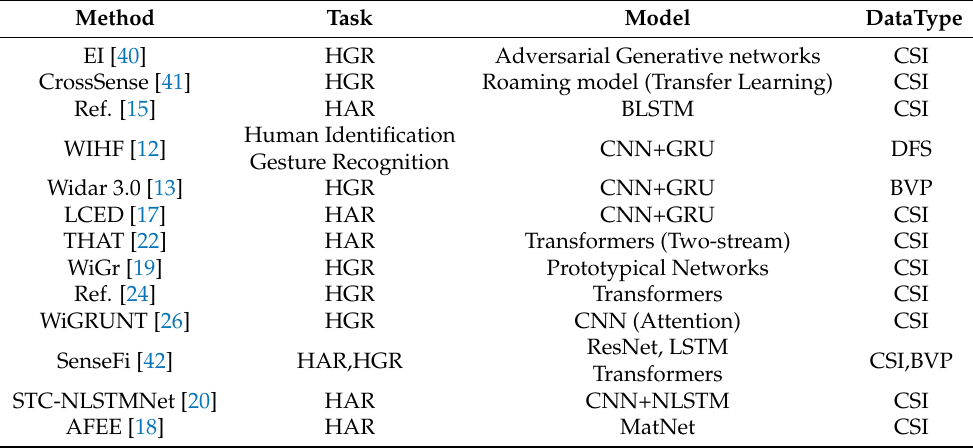
Table 1. A survey of the existing deep learning approaches for WiFi